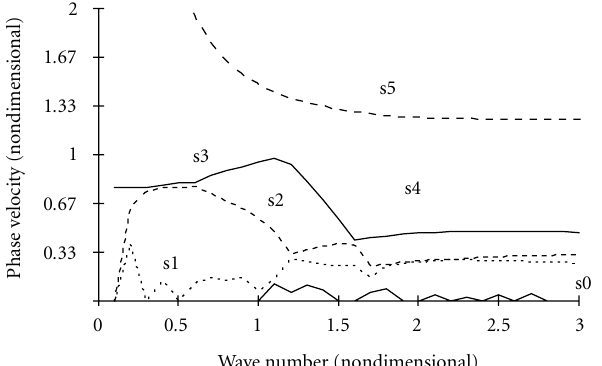
Figure 8.2. Dispersion of the first six extensional modes for τ 0 = 2 . 10 − 7 second and τ 1 = 4 . 10 − 7